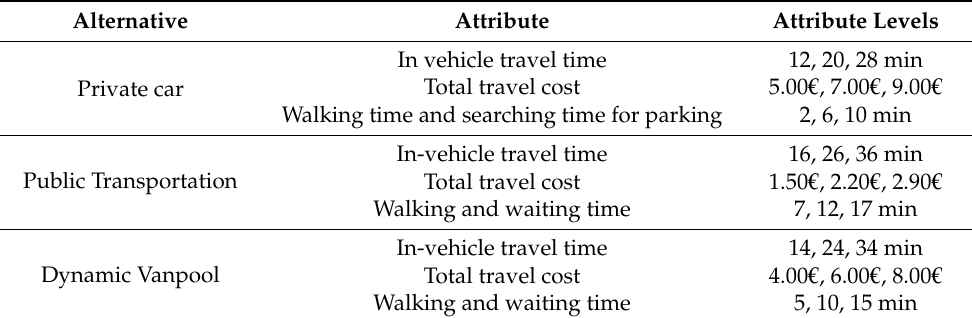
Table 1. Summary table of alternatives, attributes and attribute